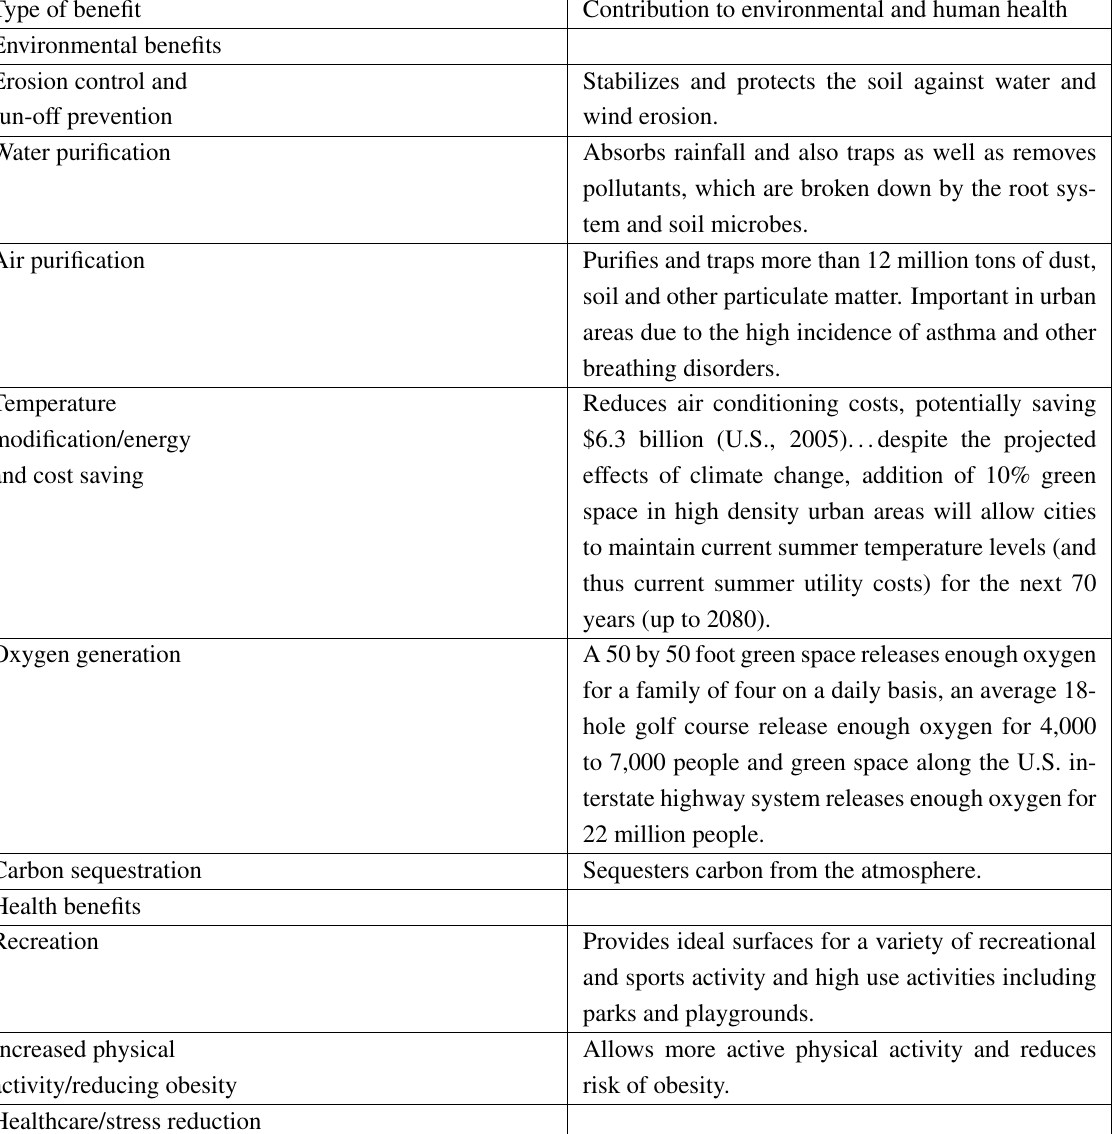
Table 1. Source of basic data: Heinze